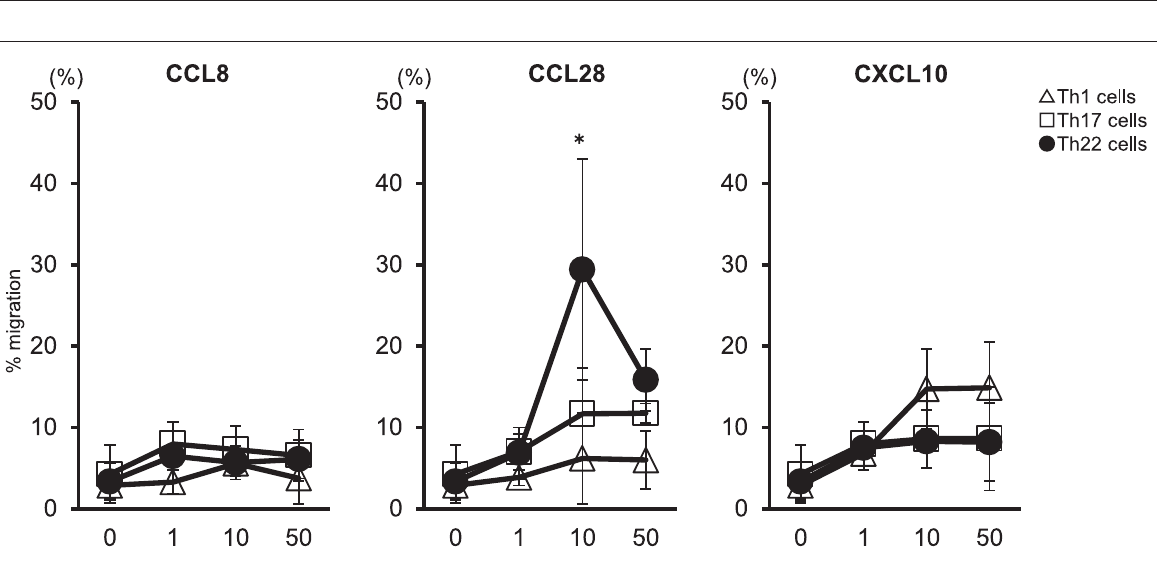
FIGURE 4 | Th22-cell migration in response to CCL28. T cell preparations were allowed to migrate toward medium alone or medium containing the indicated concentrations of CCL8, CCL28, or CXCL10. Responding cells were harvested, stained with V450-conjugated anti-CD3, V500-conjugated anti-CD4, PerCP-Cy5.5- conjugated anti-CXCR3, PE-Cy7-conjugated anti-CCR4, FITC-conjugated anti-CCR6, or PE-conjugated anti-CCR10, and their migration was quantified. Migration by Th1 cells (CD3 + CD4 + CXCR3 + : 1 ), Th17 cells (CD3 + CD4 + CXCR3 − CCR4 + CCR6 + CCR10 − : 2 ), and Th22 cells (CD3 + CD4 + CXCR3 − CCR4 + CCR6 + CCR10 + : •) is presented for each donor sample. All experiments were performed in duplicate wells for each condition. Data are representative of five donor samples tested. * p < 0.05 according to the Bonferroni